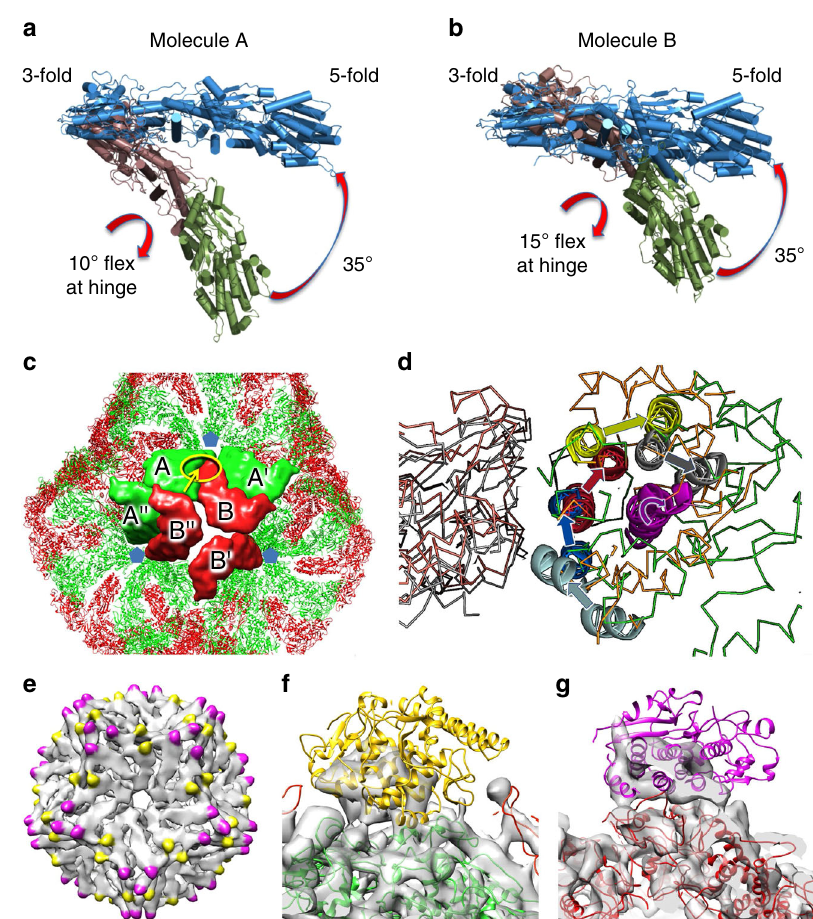
Fig. 3 Rearrangement between SLP and virion-like particles. a , b Side views of the conformational changes within the λ 1 subunits between virion-like particle (blue) and the SLP where the two portions are coloured raspberry and forest, the latter portion being closest to the fi vefold. c Interface areas between λ 1 molecules in the SLP. Highlighted in yellow is the area shown in ( d ) with the arrow indicating the viewpoint. d Close up view of the ratchet of the AB interface. The A molecules are on the left. SLP molecules A and B coloured grey and orange, respectively. Molecules A and B for the virion-like particle are coloured pink and green, respectively. To show the ratchet more clearly the A molecules of each AB pair have been superposed. For the B molecules ratchetting helices and the pivot helix are coloured equivalently for the SLP and the virus (the pivot helix is shown in purple). Arrows show the rotation between the SLP and virus. e SLP density (PEET map) unaccounted for by λ 1. Within the icosahedral asymmetric unit there are two distinct sets of density, one close to the twofold is coloured yellow, the other close to the threefold is coloured magenta. f , g close up of the densities shown in yellow and purple in ( e ). σ 2 cartoons roughly positioned in the